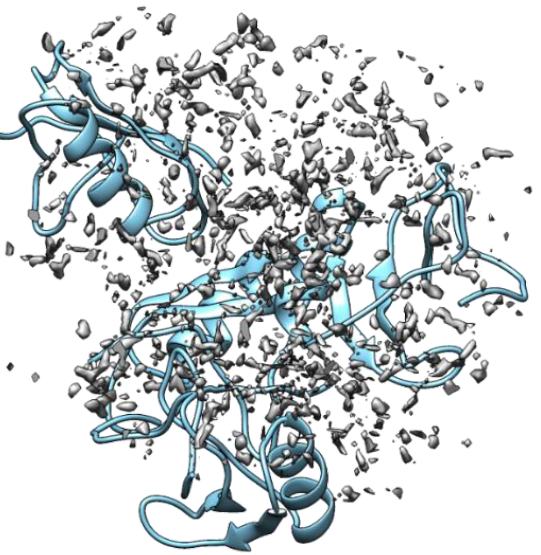
Figure 2. The normalized distribution of the water oxygen sites around the scorpion toxin protein (PDB ID: 1AHO) computed using the 3D-RISM-KH theory and the modified TIP3P water model. The protein backbone is colored in cyan.